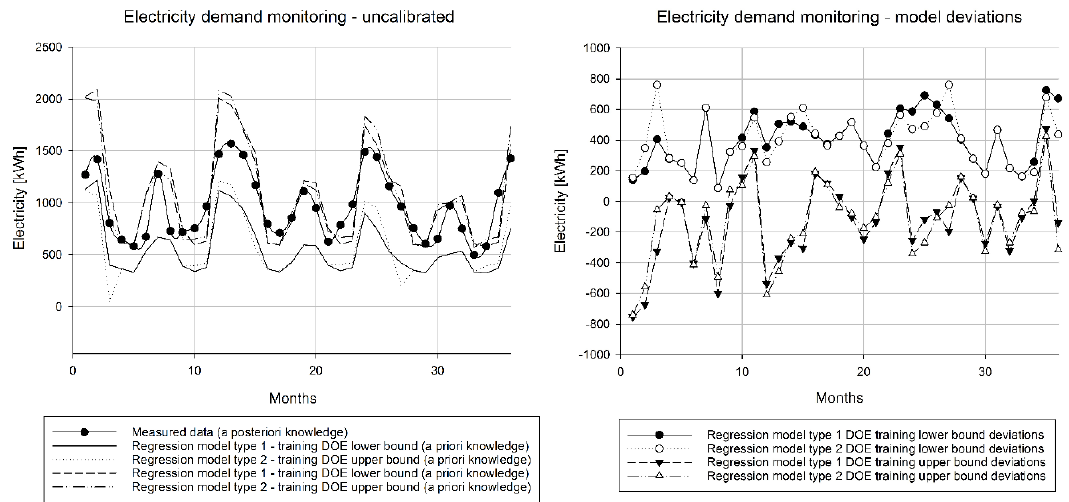
Figure 5. Electricity demand monitoring—comparison between measured data, regression model type 1 and type 2 lower bound and upper bound and deviations between measured and predicted data.